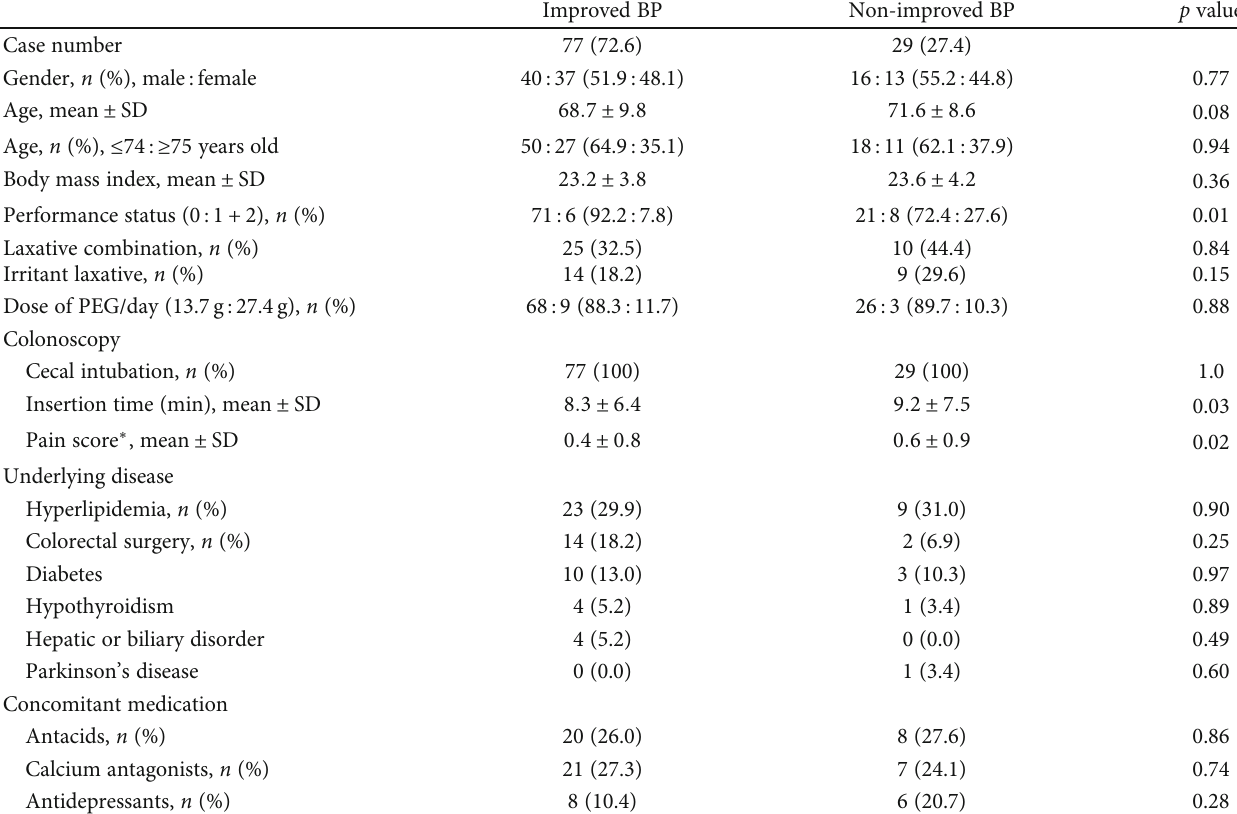
Table 2: The comparison between cases with and without improvement of bowel preparation.